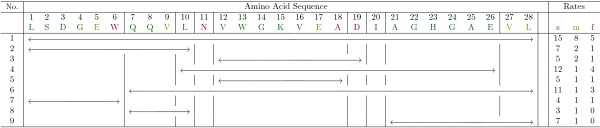
Sample data set. Overlap of peptic fragments obtained from our sHDX on myoglobin. The table on the right shows the number of amide hydrogens predicted to be either slow, medium or fast (based on MEM). The vertical lines show the decomposition of the sequence into parts induced by the fragments. We want to automatically draw conclusions on the exchange rates of single amino acids, like the one that the second D residue has to have medium exchange rate, concluded from the restrictions imposed by fragments 3 and 5. Notice that we already deleted the N-terminal amino acid as we cannot see them exchange.